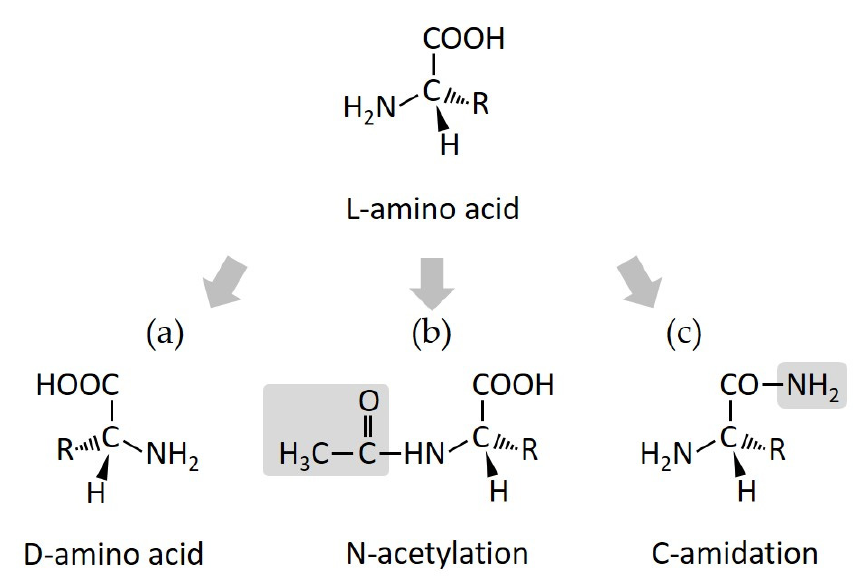
Figure 2. Structural modification. ( a ) L- to D-amino acid substitution, ( b ) N-acetylation, and ( c ) C- amidation.